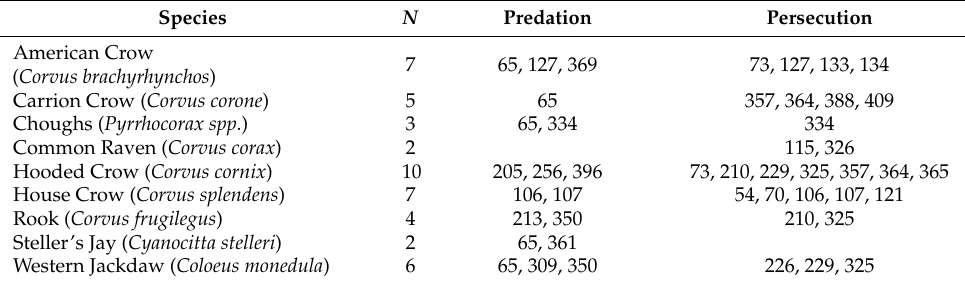
Table 6. List of articles reporting predation events and persecution towards to corvids in urban areas ( n = 30). The reference numbers in the table refer to the individual publication numbers given in Table